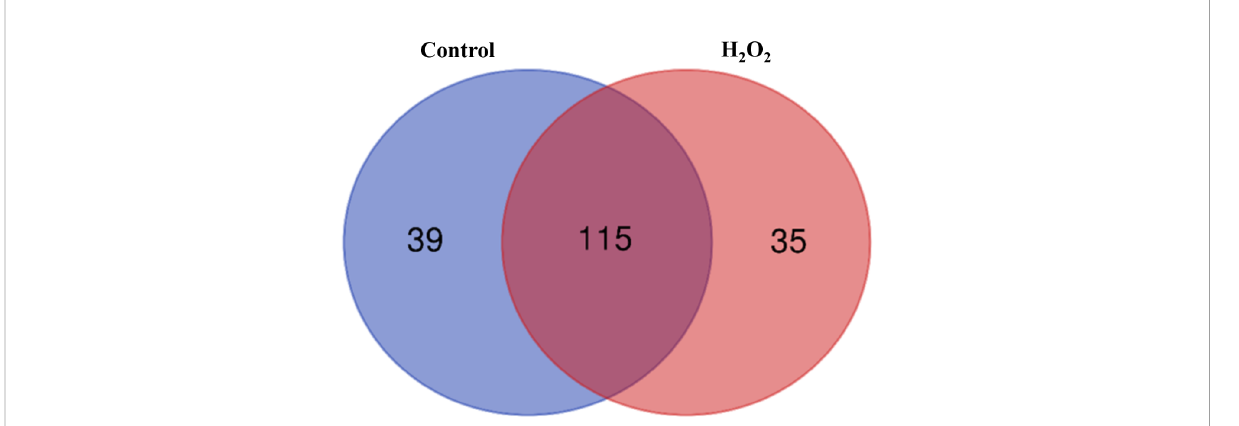
FIGURE 2 A Venn diagram of the carbonylated proteins in the control plant samples and the H 2 O 2 -treated plant samples. The diagram was generated from the carbonylated proteins identi fi ed in all three biological replicates of the